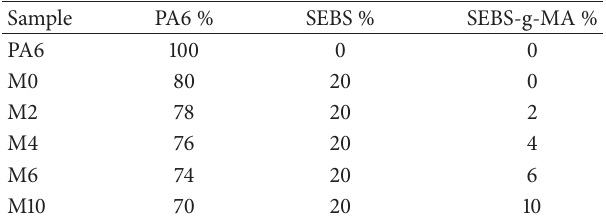
Table 1: Formulation of the polyamide